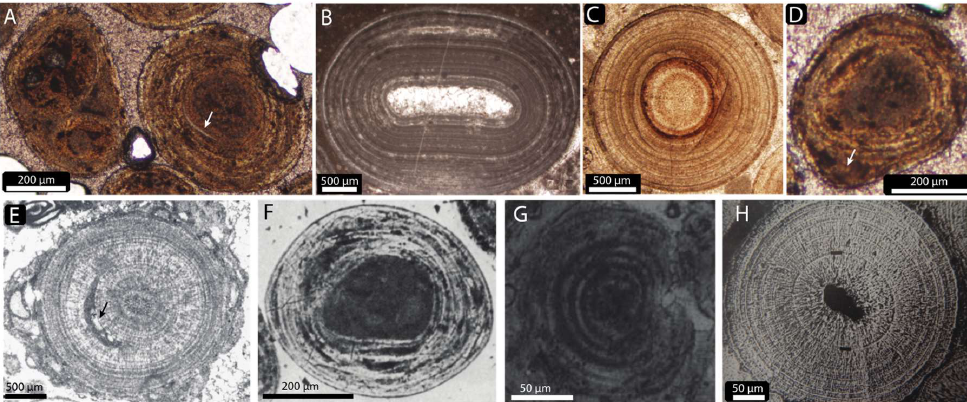
Figure 11. Examples of ooid petrography. ( A ) Large (~500 µm) ooids from the headland site of Pigeon Cay (Figure 1). Note the presence of multiple nuclei (on the left), irregular laminae (arrow), and the absence of outward thinning of successive laminae. ( B , C ) Neoproterozoic ooids from the Beck Spring Formation ( B ) and Cambrian ooids from the Man o’ War Member of western Newfoundland ( c ), both showing successive laminae that do not thin outward. ( D ) Recent Bahamian ooid showing a lens-shape inclusion of unoriented aragonite. ( E ) Triassic ooid with encrusting foraminifera [73]. ( F ) Recent Bahamian ooid with irregular laminae [74]. ( G ) Benthic ooid from a modern hypersaline microbial mat showing regular laminae [75]. ( H ) Jurassic ooid showing regularity of individual laminae and outward thinning of successive laminae [71].